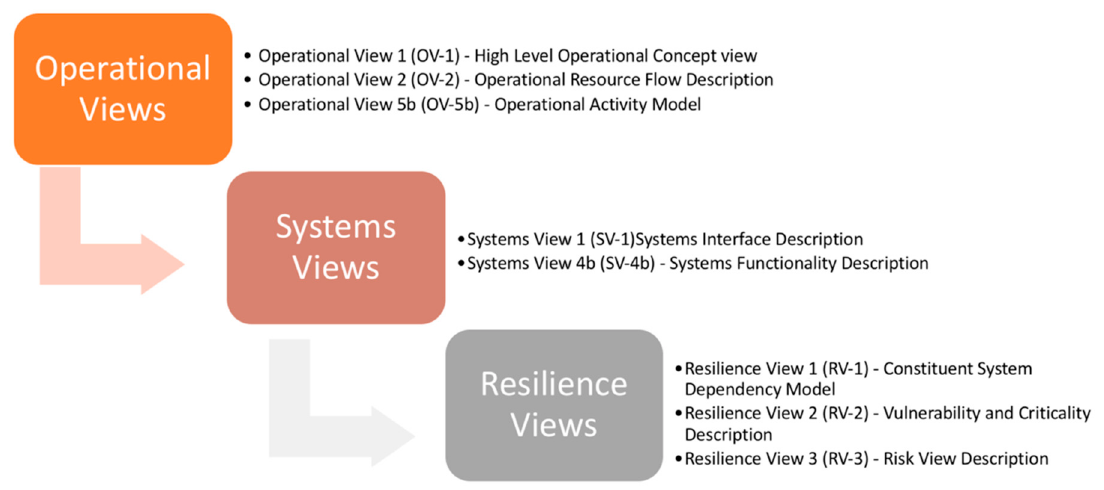
Figure 4. Architecture modelling views process .